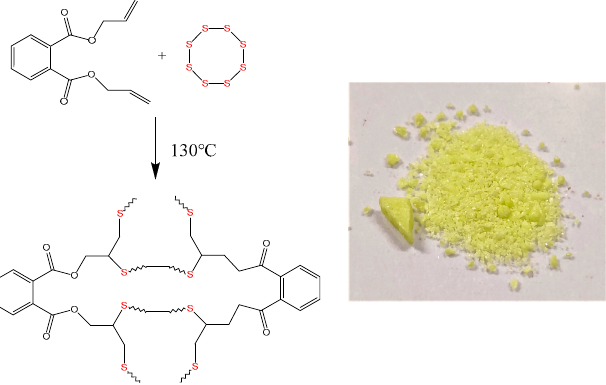
Figure 1. The reaction formula of poly (sulfur-diallyl-o-phthalate) (poly(S-DAP)) copolymer and the product photograph.